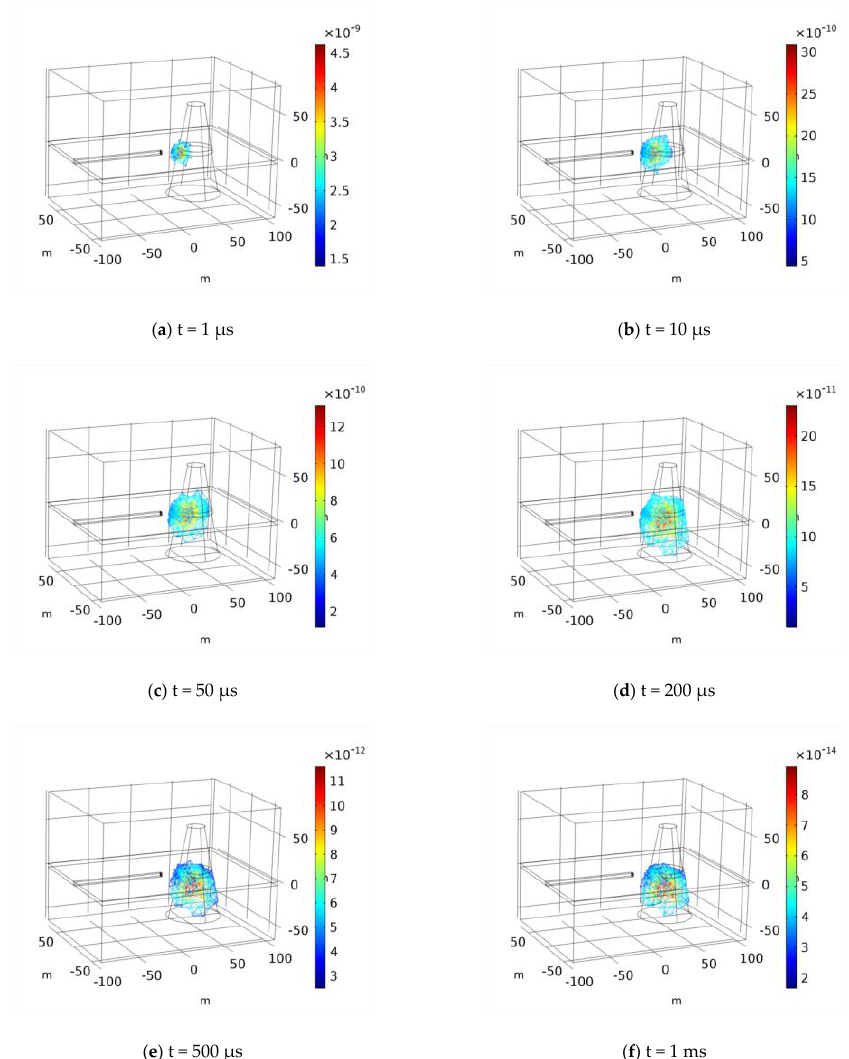
Figure 7. Law of 3D electromagnetic response in full space with water-containing collapse columns.